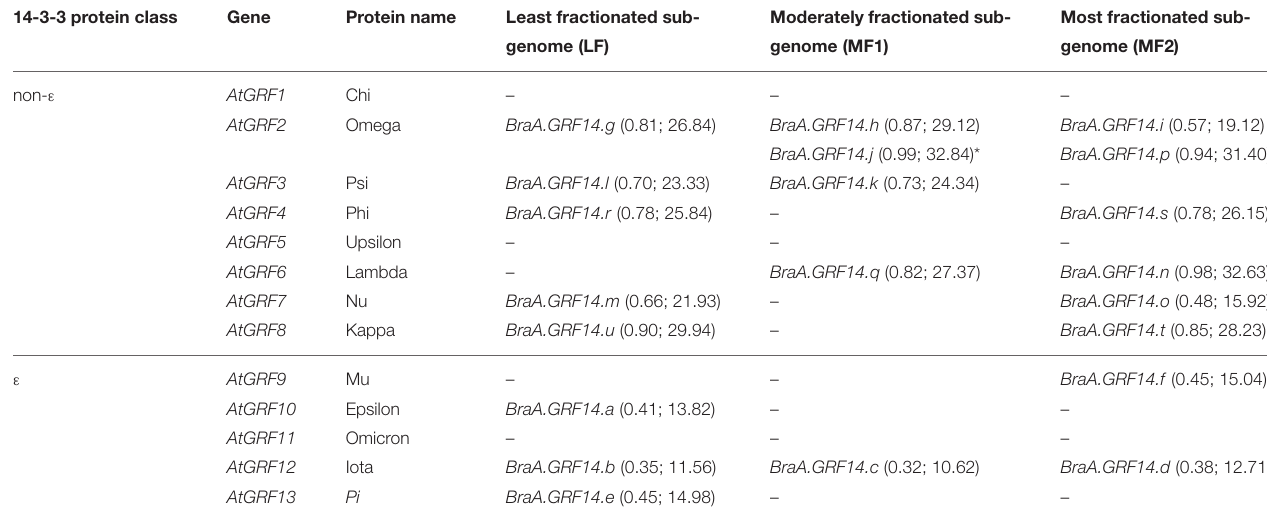
TABLE 2 | Gene fractionation and divergence analysis of syntenic 14-3-3 genes identified in the three sub-genomes of B. rapa (http://brassicadb.org/brad/) with their corresponding Arabidopsis